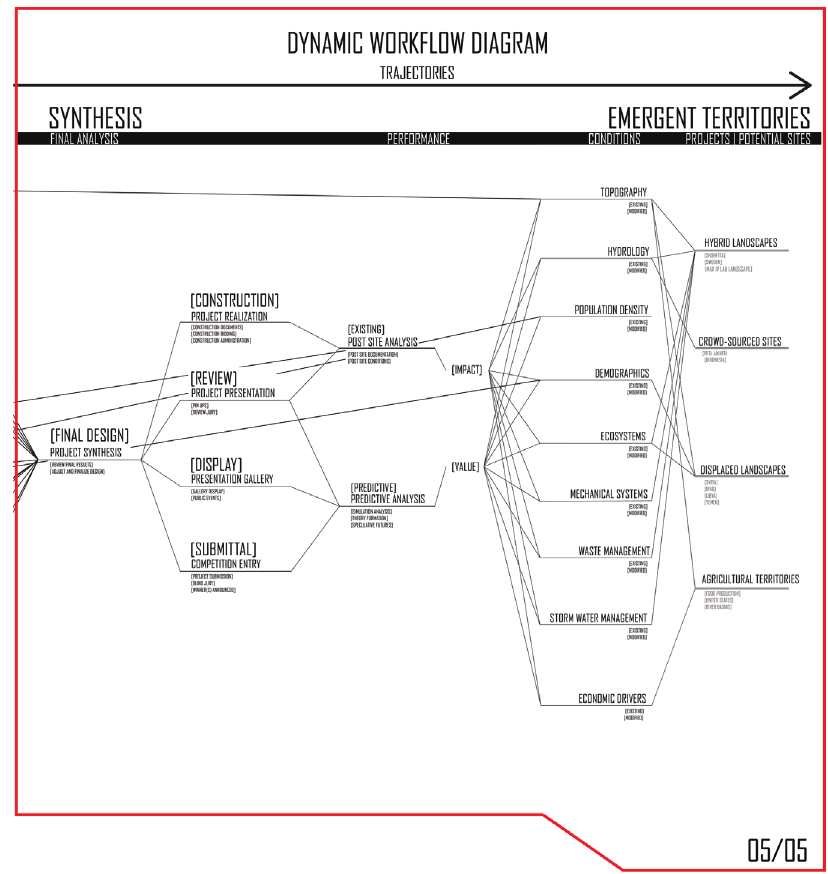
Figure 5: Enlarged segments of the workflow diagram (5/5). The segment shows a few examples of emerging territories such as refugee camps as it establishes a link to assess their impact and gauge paths to their